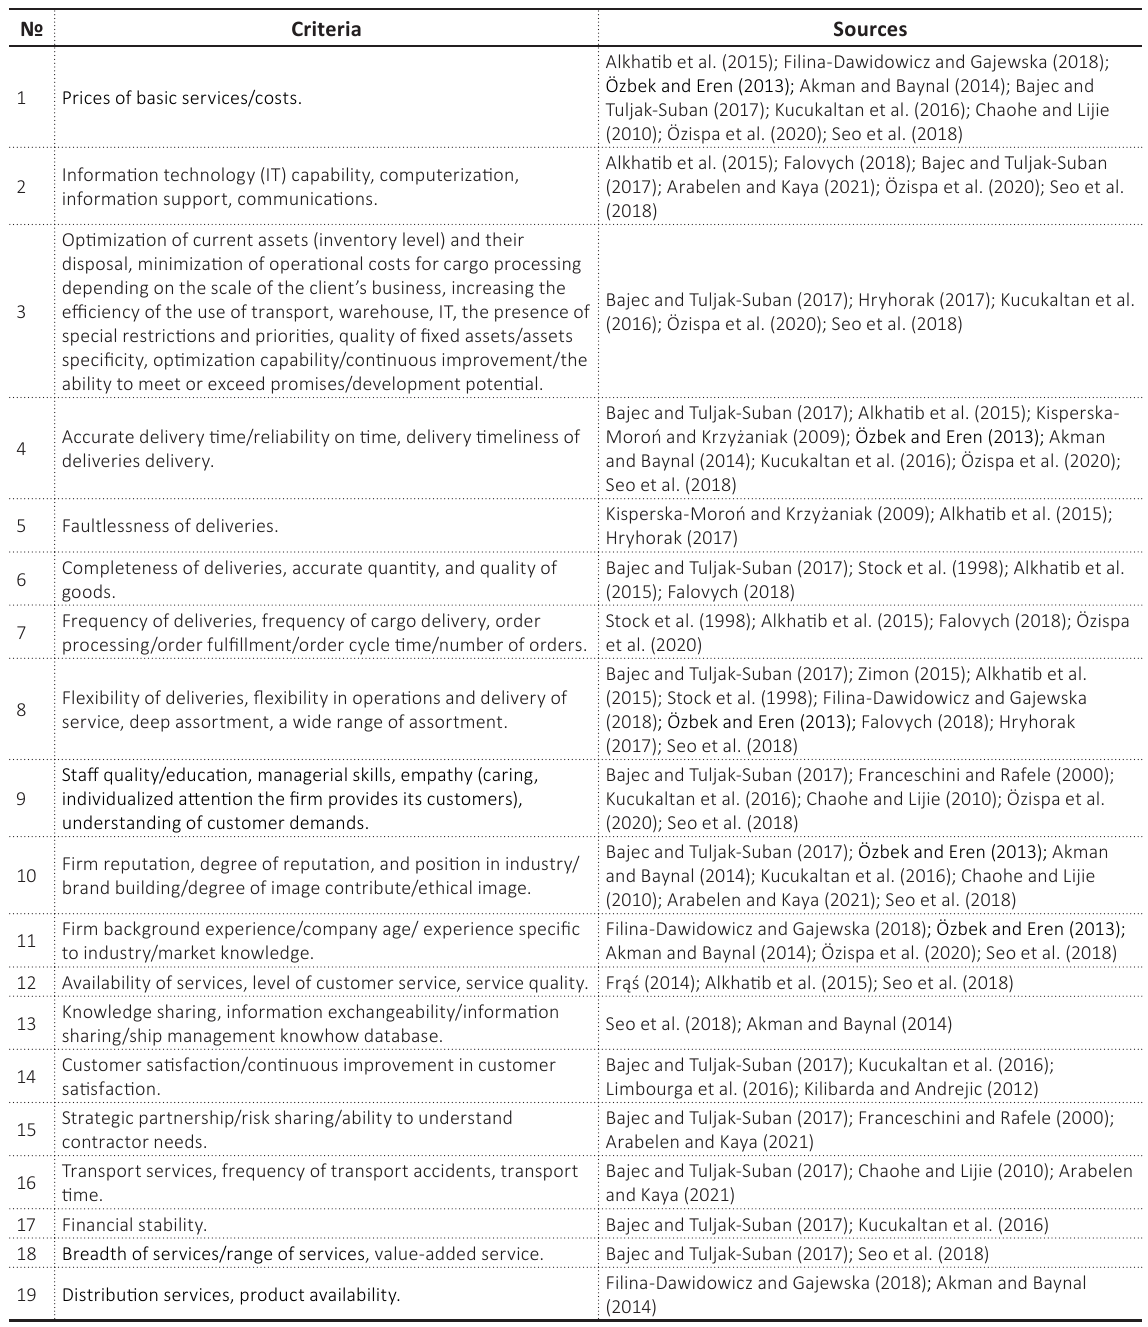
Table 1. Criteria for evaluating the logistics service